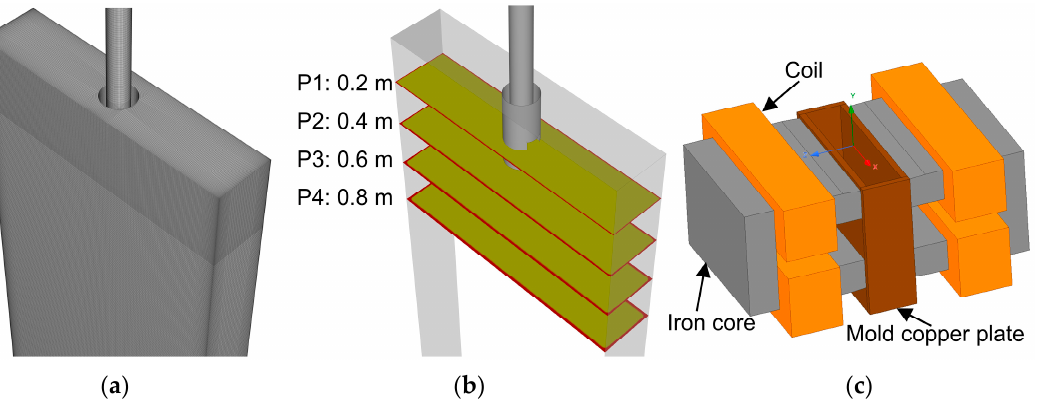
Figure 1. Schematic diagram of numerical simulation: ( a ) structured grid of mold; ( b ) reference planes; ( c ) double-ruler EMBr device. Table 1. Continuous casting parameters and material physical parameters.